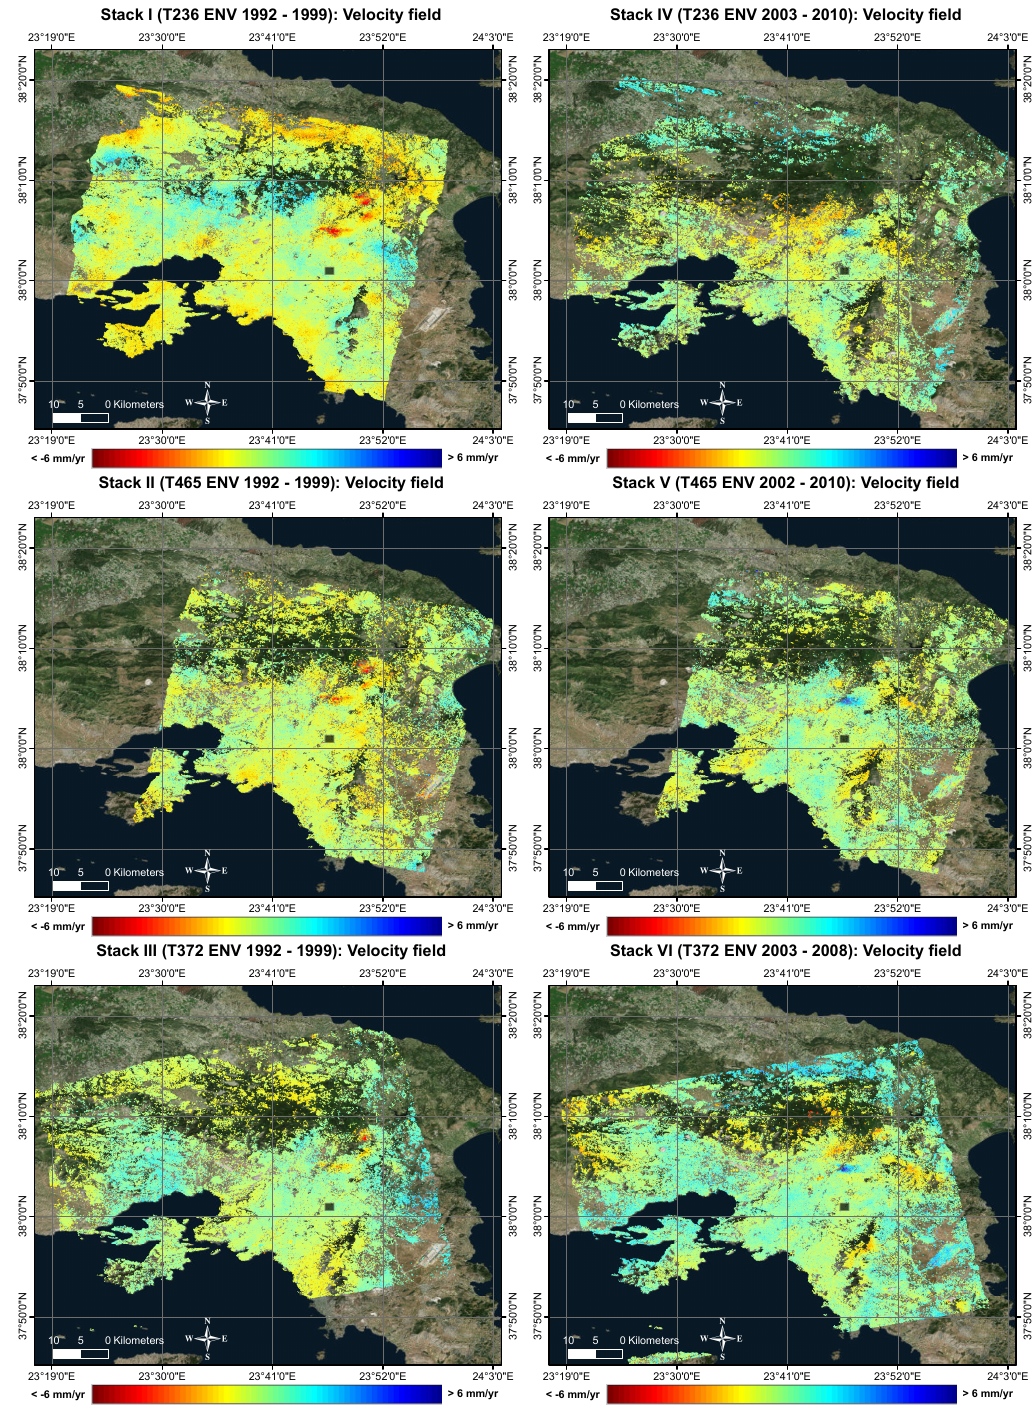
Figure 4. LOS velocity field for all six interferometric stacks. The black box is the reference area. The left column contains ground velocity maps under different viewing angles for the period 1992–1999, while the right column contains the corresponding maps for the period 2002–2010. The displacement patterns for the adjacent descending tracks processed are quite similar, providing intra-track cross-validation based on independent datasets. Discrepancies observed between descending and ascending tracks of the same observation period are further analyzed to estimate vertical and horizontal ground velocity